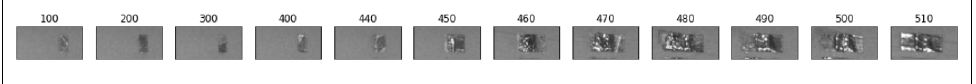
Figure 5. Picture of bar1 at various layers during printing. The layer number is displayed on top of each layer image.